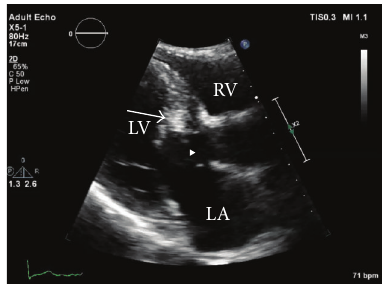
Figure 1: Preoperative Transthoracic Echocardiogram, Parasternal Long Axis. LA: left atrium; LV: left ventricle; RV: right ventricle; arrow: interventricular septal mass; arrow head: left ventricular outflow tract.